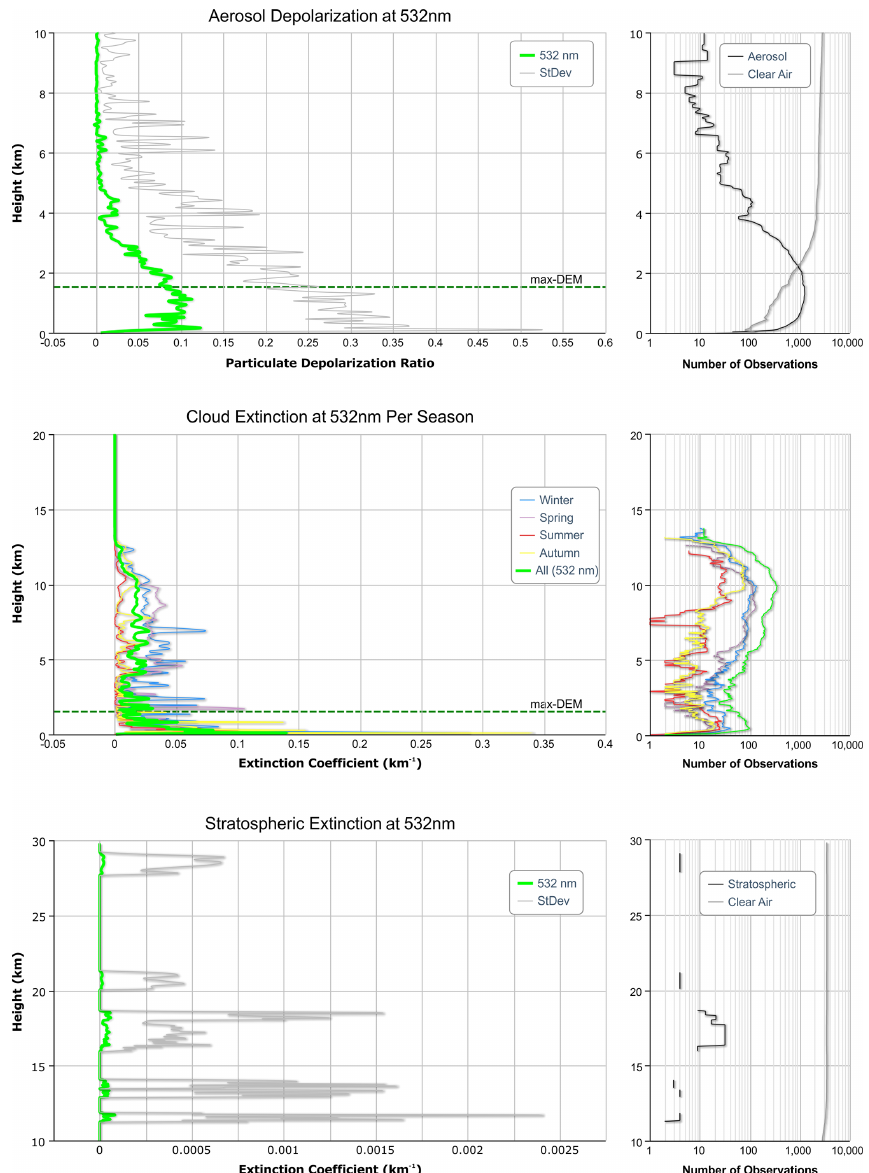
Figure 11. Additional LIVAS products. Upper panel: vertical distribution of the averaged particle depolarization at 532nm (left), number of observations used in averaging (right). Middle panel: vertical distribution of the averaged cloud extinction coefficient per season (left), number of observations used in averaging (right). Lower panel: vertical distribution of the averaged stratospheric aerosol extinction coefficient (left), number of observations used in averaging